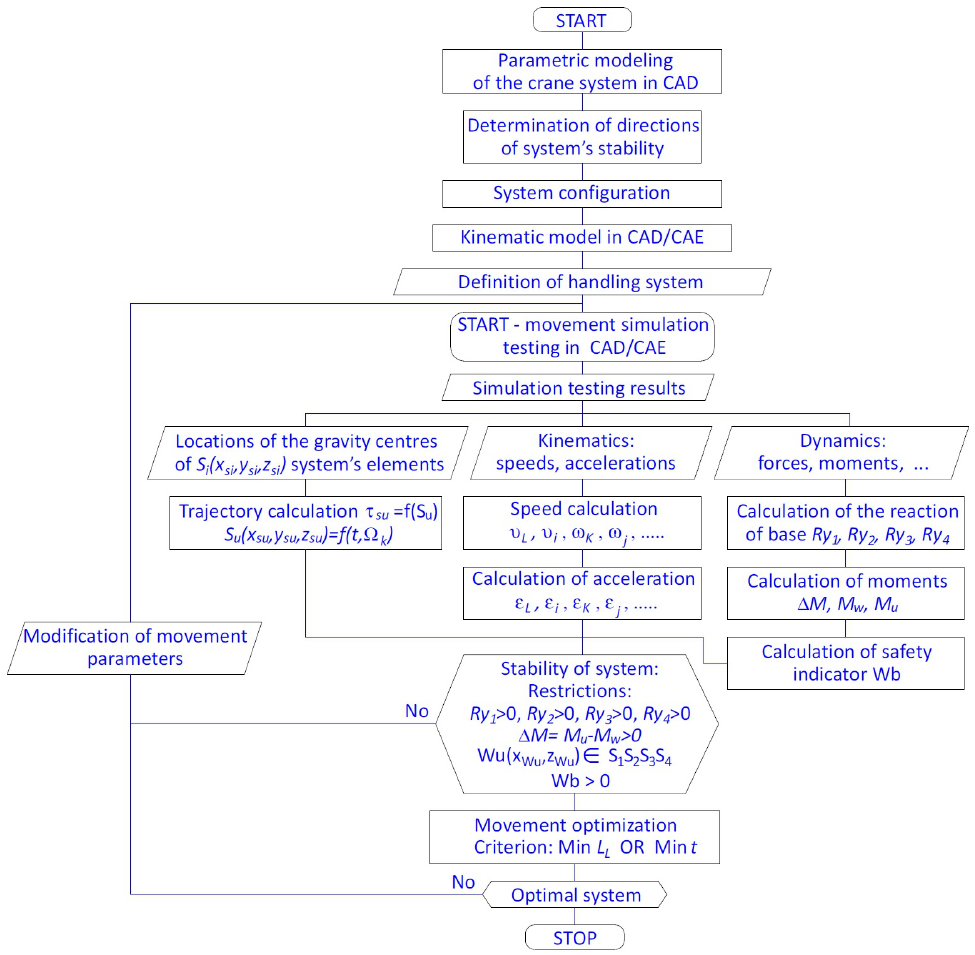
Figure 2. Block diagram of computer-aided assessment of the stability of the crane handling system